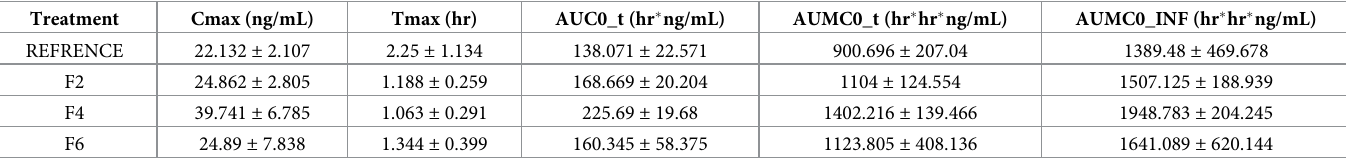
Table 3. In vivo pharmacokinetic parameters & data represent the mean value ± standard deviation (SD). Treatment